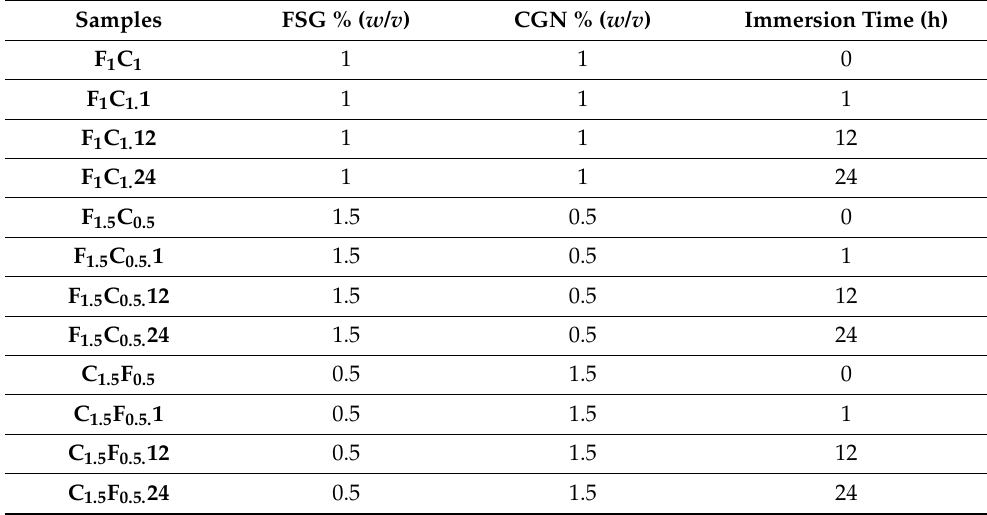
Table 1. Composition of the non-crosslinked and crosslinked biocomposite hydrogel films. Samples FSG % ( w / v ) CGN % ( w / v ) Immersion Time